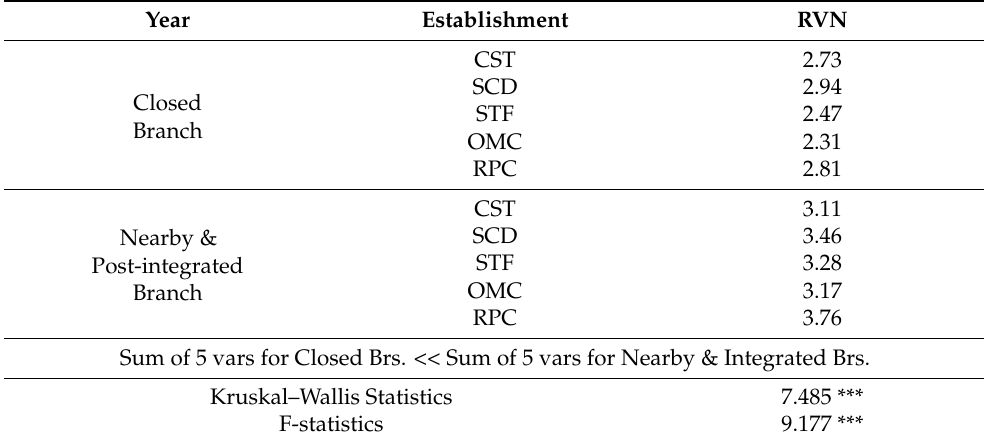
Table 16. The test for generalized forecast error variance decomposition